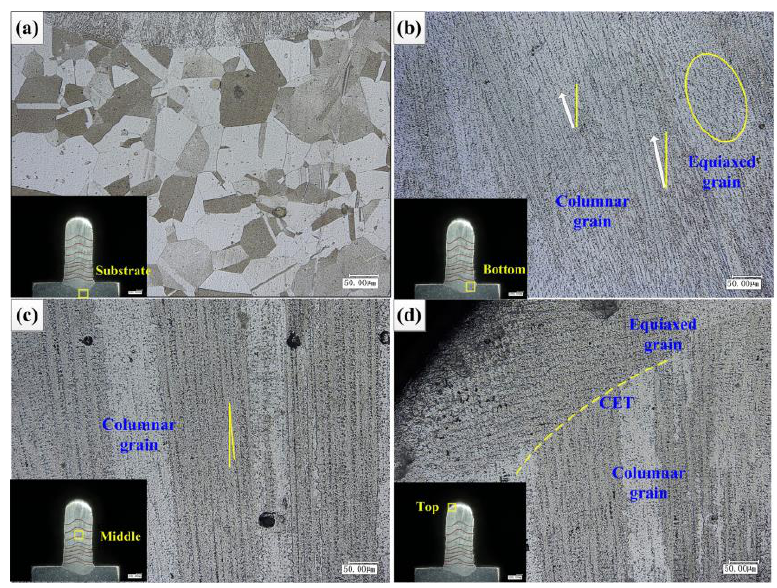
Figure 16. Morphology of cross section of cladding layer: ( a ) substrate, ( b ) bottom, ( c ) middle, ( d ) top. Observation of longitudinal section microstructure of cladding layer [30] is